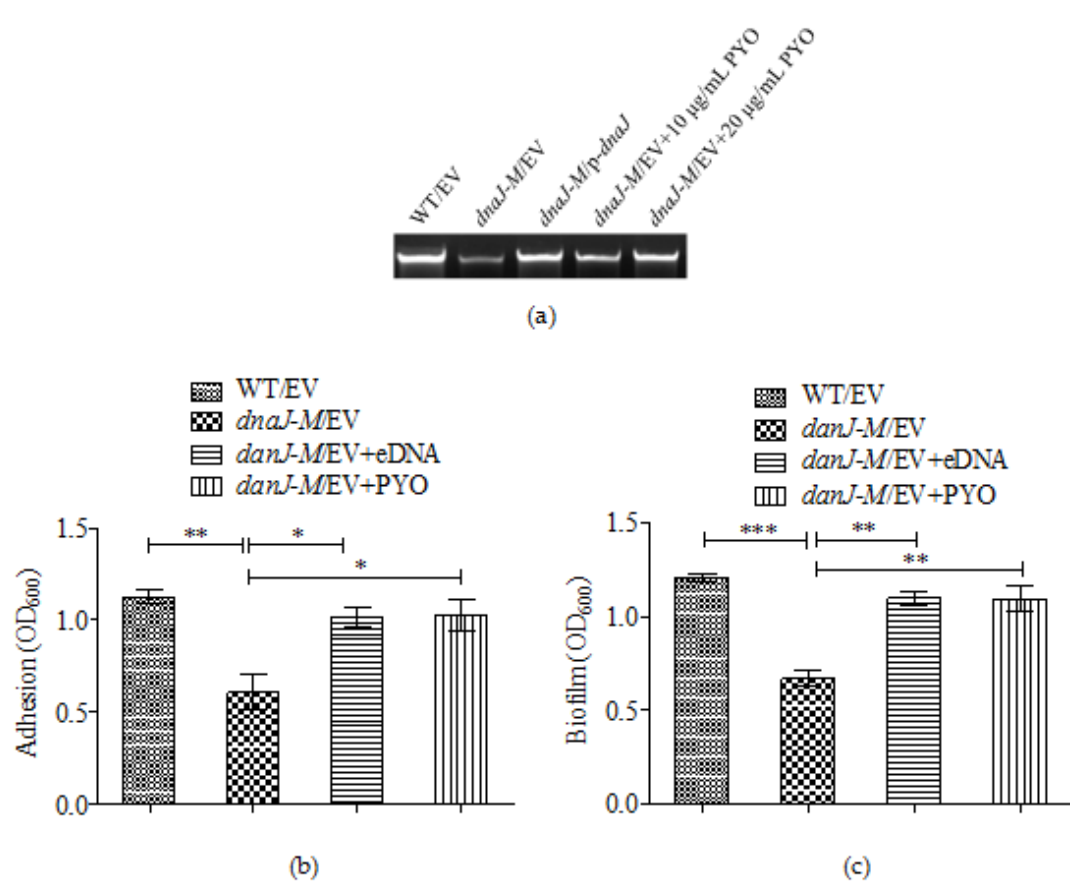
Figure 5. The contribution of eDNA and PYO to adhesion and biofilm production. ( a ) eDNA production in WT, dnaJ-M , and complementation strains. eDNA productions of dnaJ-M with exogenous pyocyanin at 10 µg/mL and 20 µg/mL (final concentration) are also shown. ( b ) The initial adhesion and ( c ) biofilm formation in WT, dnaJ-M and dnaJ-M with exogenous eDNA at 2 µg/mL (final concentration) or pyocyanin at 10 µg/mL Averages of triplicate experiments ± standard errors of the means are shown. A two-tailed unpaired t -test was performed using GraphPad software version 5.0 (*, p < 0.05; **, p < 0.01; ***, p < 0.001). EV: empty vector control. p- dnaJ : dnaJ complementation construct.